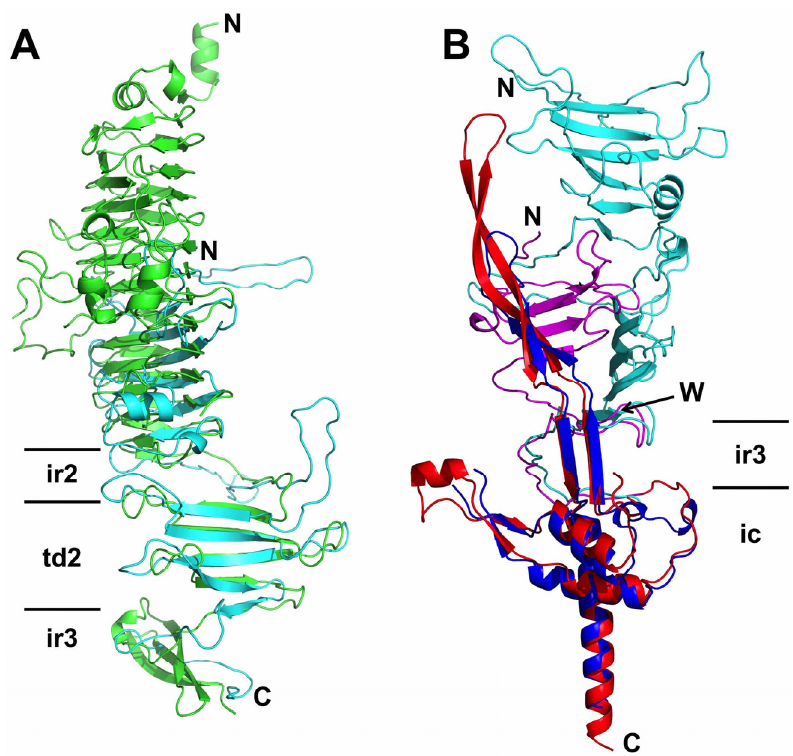
Figure 4. Structural superposition of the phage T5 L-shaped fibre domains with homologous structures. ( A ) Superposition of a monomer pb1(970–1263) in cyan and P22 tailspike protein (113–666) (PDB 1TSP) in green; ( B ) Pb1(970–1396) in cyan with its intra-molecular chaperone domain in